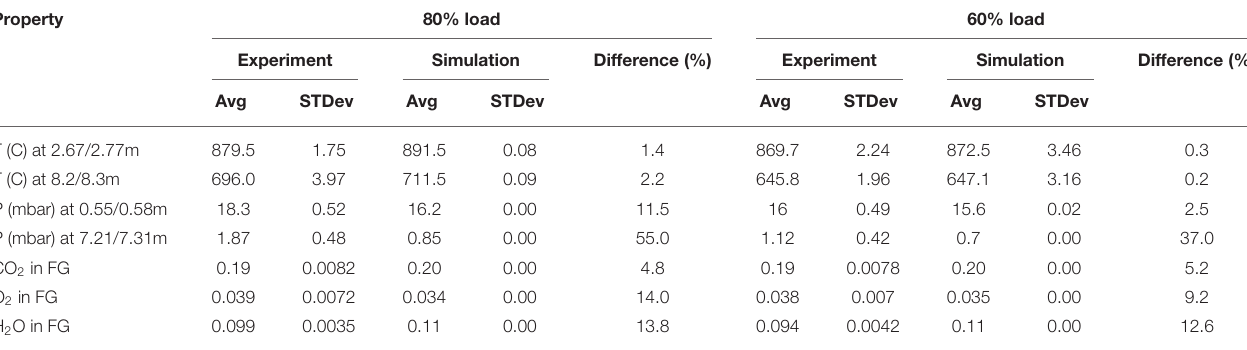
TABLE 5 | Average values and standard deviations of the examined properties as predicted by the transient simulation and the experiment for the 80% and 60% loads. Property 80% load 60% load Experiment Simulation Difference (%) Experiment Simulation Difference (%) Avg STDev Avg STDev Avg STDev Avg